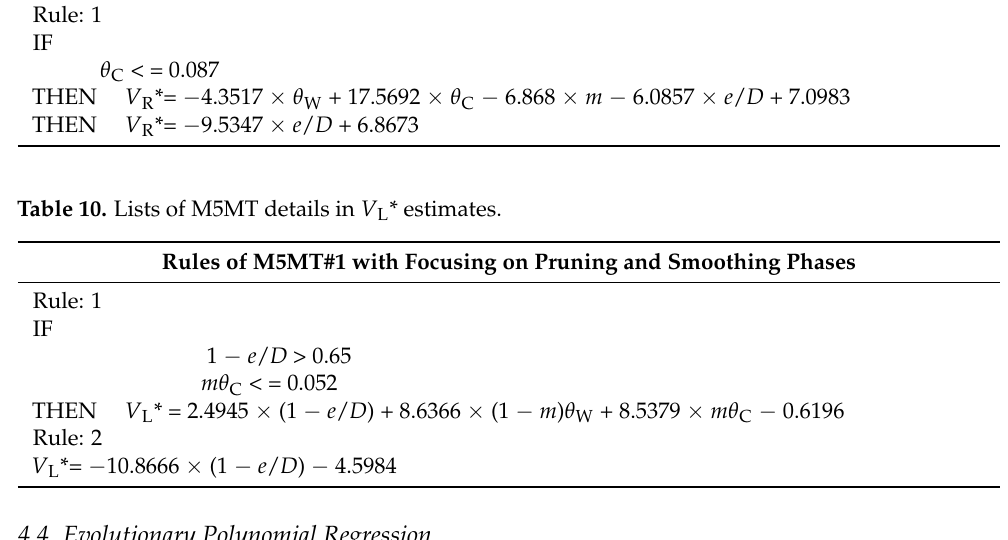
Table 9. Lists of M5MT details in V R * estimates. Rules of M5MT#1 with Focusing on Pruning and Smoothing Phases